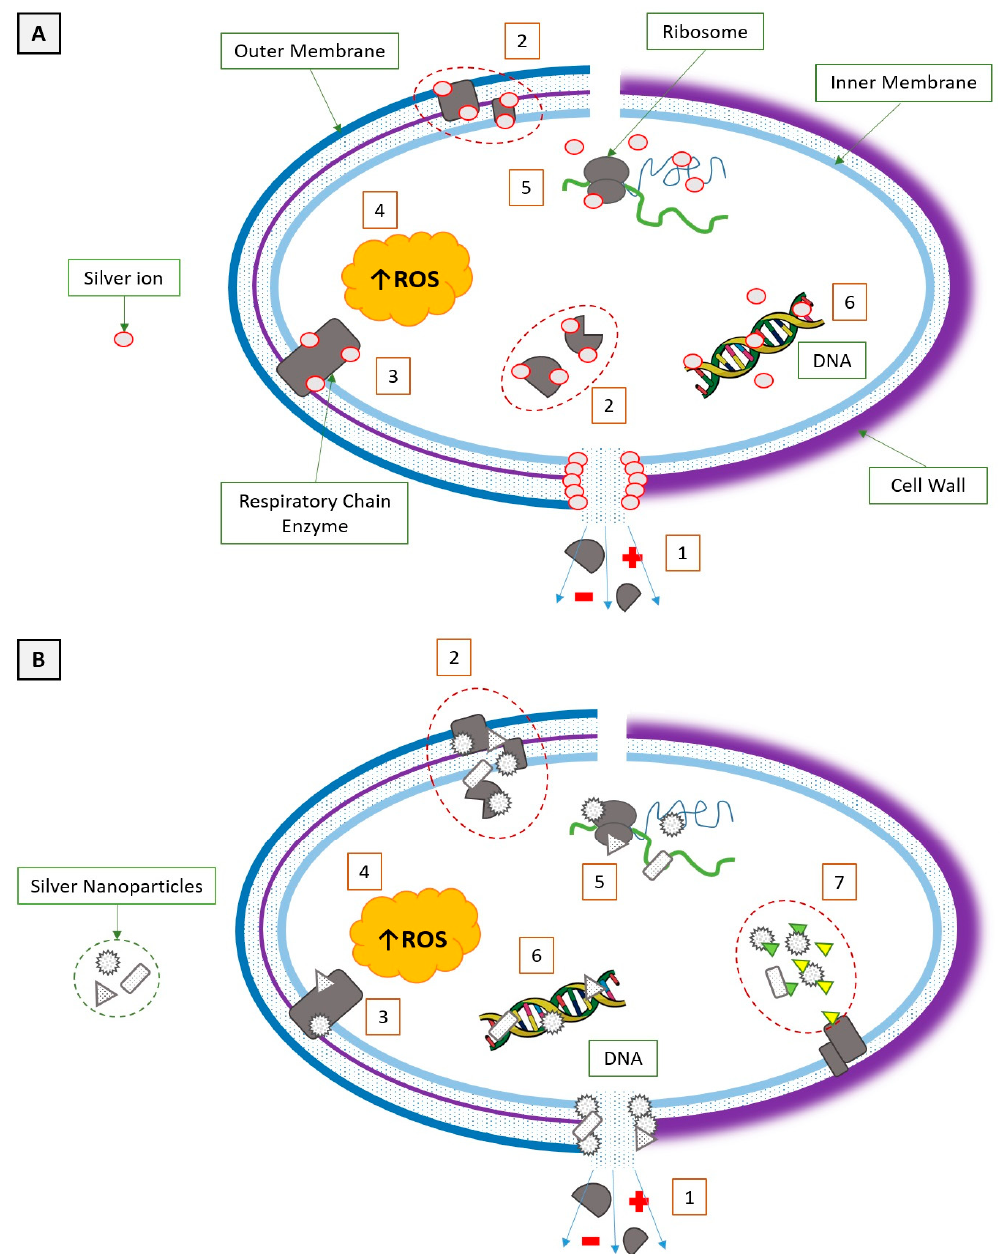
Figure 3. A comparison of the silver ions ( A ) and silver nanoparticles’ ( B ) mode of action to Gram- negative ( left ) and Gram-positive ( right ) bacteria. (1) Pore formation; metabolites and ions leakage (shown as plus and minus in the figure above) (2) Denaturation of structural and cytoplasmic proteins; enzymes inactivation. (3) Inactivation of respiratory chain enzymes. (4) Increase of intracellular reactive oxygen species (ROS) concentration. (5) Interaction with ribosome. (6) Interaction with nucleic acids. (7) Inhibition of signal transduction.